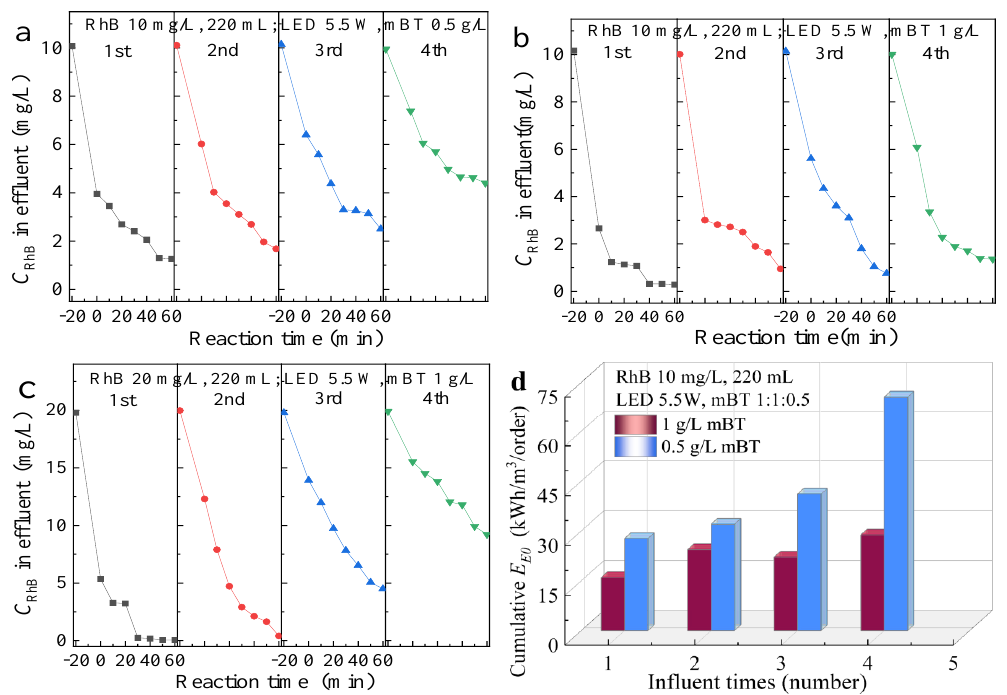
Figure 6. Comparison of the photodegradation stability of mBT with different dosages (( a ) vs. ( b )) and initial concentrations of RhB (( b ) vs. ( c )), and the accumulative electric energy consumption of the mBT − MPR system under different mBT dosages ( d ).